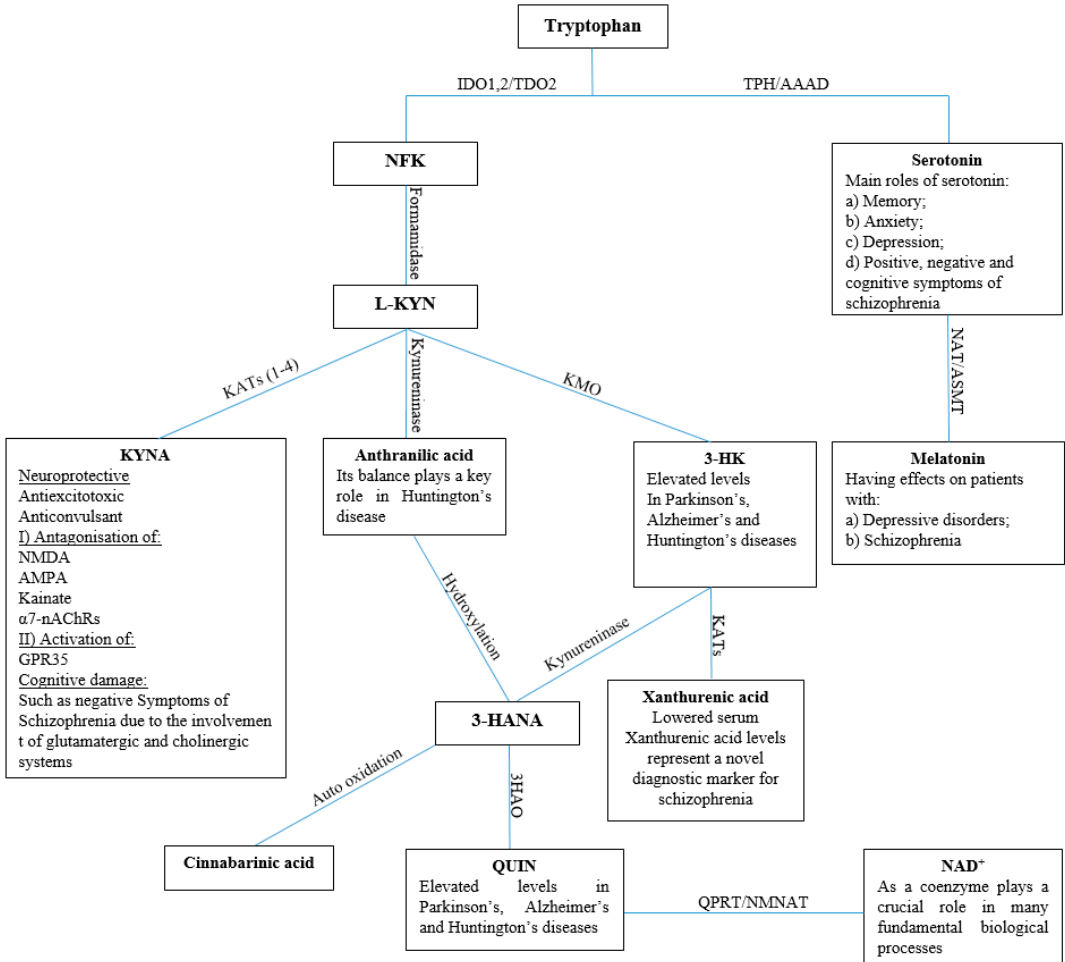
Figure 1. The tryptophan catabolic pathway consists of two routes. One is serotonin biosynthesis, the route which is determined by the amount of tryptophan which can cross the blood-brain barrier (BBB). As illustrated, two enzymes transform tryptophan into serotonin: first tryptophan hydroxylase (TPH) hydroxylates tryptophan into 5-hydroxytryptophan and then in the second step L -aromatic amino acid decarboxylase (AAAD) decarboxylases 5-hydroxytryptophan into serotonin. Serotonin is consequently transformed to an active metabolite, melatonin, via two-steps of enzymatic catabolism. Firstly, serotonin is transformed to N -acetylserotonin via acetylation of its amine group by N -acetyl transferase (NAT), and then acetylserotonin O -methyltransferase (ASMT) catalyzes the subsequent transformation, converting normelatonin to melatonin. The second route is known as the kynurenine pathway, which is the main route of tryptophan metabolism. This pathway is started by the conversion of tryptophan to N -formylkynurenine (NFK) by indoleamine 2,3-dioxygenase 1 (IDO1) and tryptophan 2,3-dioxygenase 2 (TDO2). L-KYN is obtained by the metabolism of NFK by formamidase. There are three branches for subsequent L-KYN metabolism. One is in which it is converted irreversibly into KYNA by kynurenine aminotransferases (KATs) isozymes. In the other branches, kynurenine 3-monooxygenase (KMO) and kynureninase transform L-KYN into 3-hydroxykynurenine (3-HK) and anthranilic acid, respectively. After that, anthranilic acid and the 3-HK are transformed by hydroxylation or kynureninase to a mutual product: 3-hydroxyanthranilic acid (3-HANA), and in the second step of the branch the 3-HK acts as a substrate of the KAT isoenzymes, and is catalysed into xanthurenic acid. An auto oxidation reaction converts 3-HANA into cinnabarinic acid; alternatively, 3-HANA is transformed into quinolinic acid (QUIN) by 3-hydroxyanthranilic acid 3,4-dioxygenase (3HAO). In the last steps of this branch, one of the crucial mammalian cofactors, nicotinamide adenine dinucleotide + (NAD + ), is produced by quinolinate phosphoribosyl transferase (QPRT) and nicotinamide nucleotide adenylyl transferase (NMNAT), respectively.